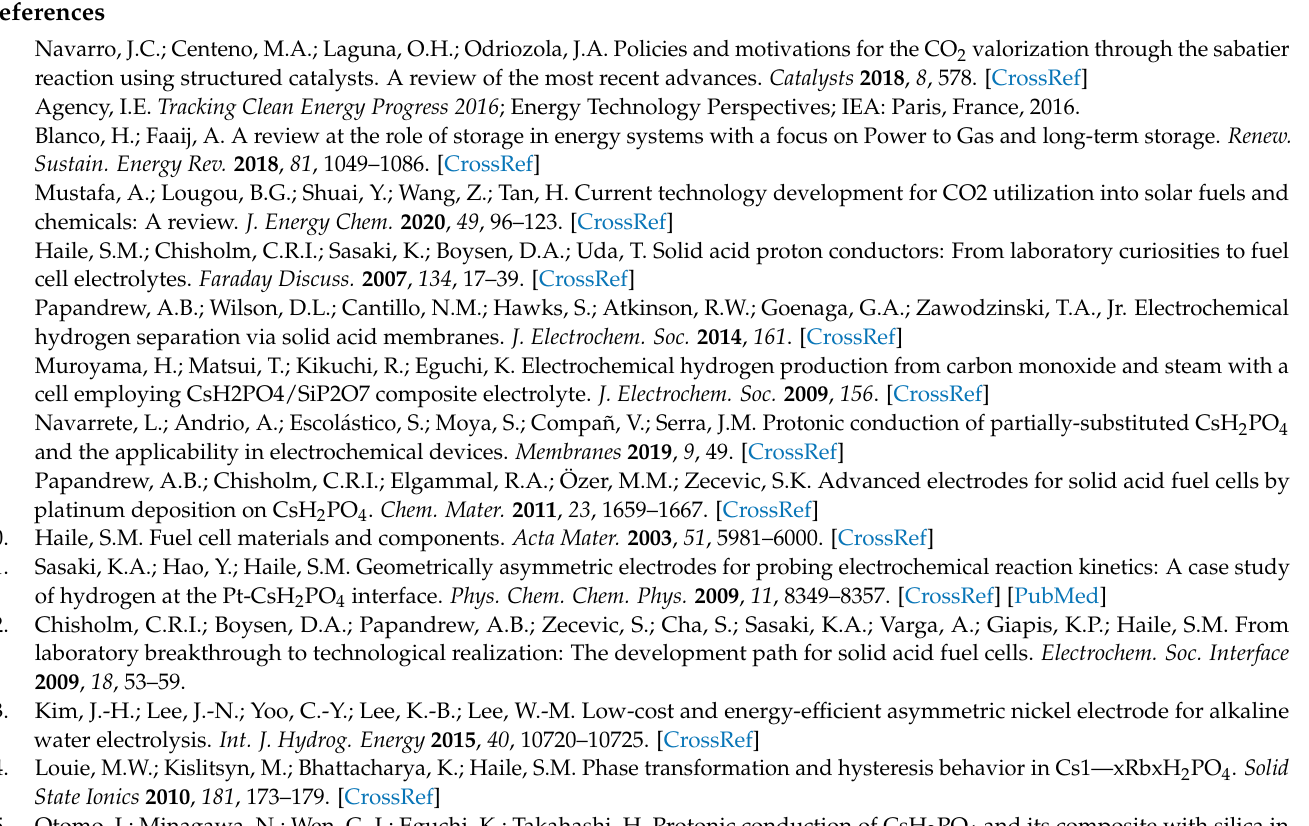
Figure S2: Equivalent electrical circuit fitting results: (a) resistance, (b) capacitance, and (c) frequency at High Frequency; (d) resistance, (e) capacitance, and (f) frequency of Low Frequency 1 (LF1); (g) resistance, (h) capacitance, and (i) frequency at LF2 of Ni sponge, Ni sponge +Ni, and Ni sponge + Co 3 O 4 at different